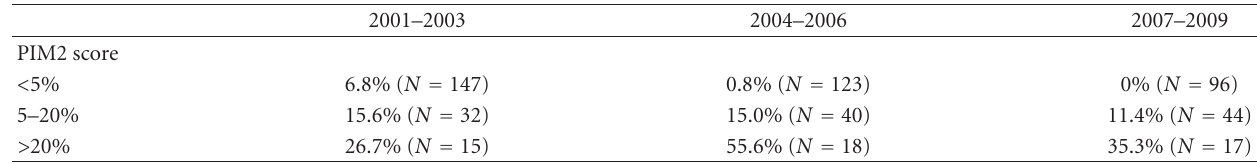
Table 3: Mortality according to PIM2